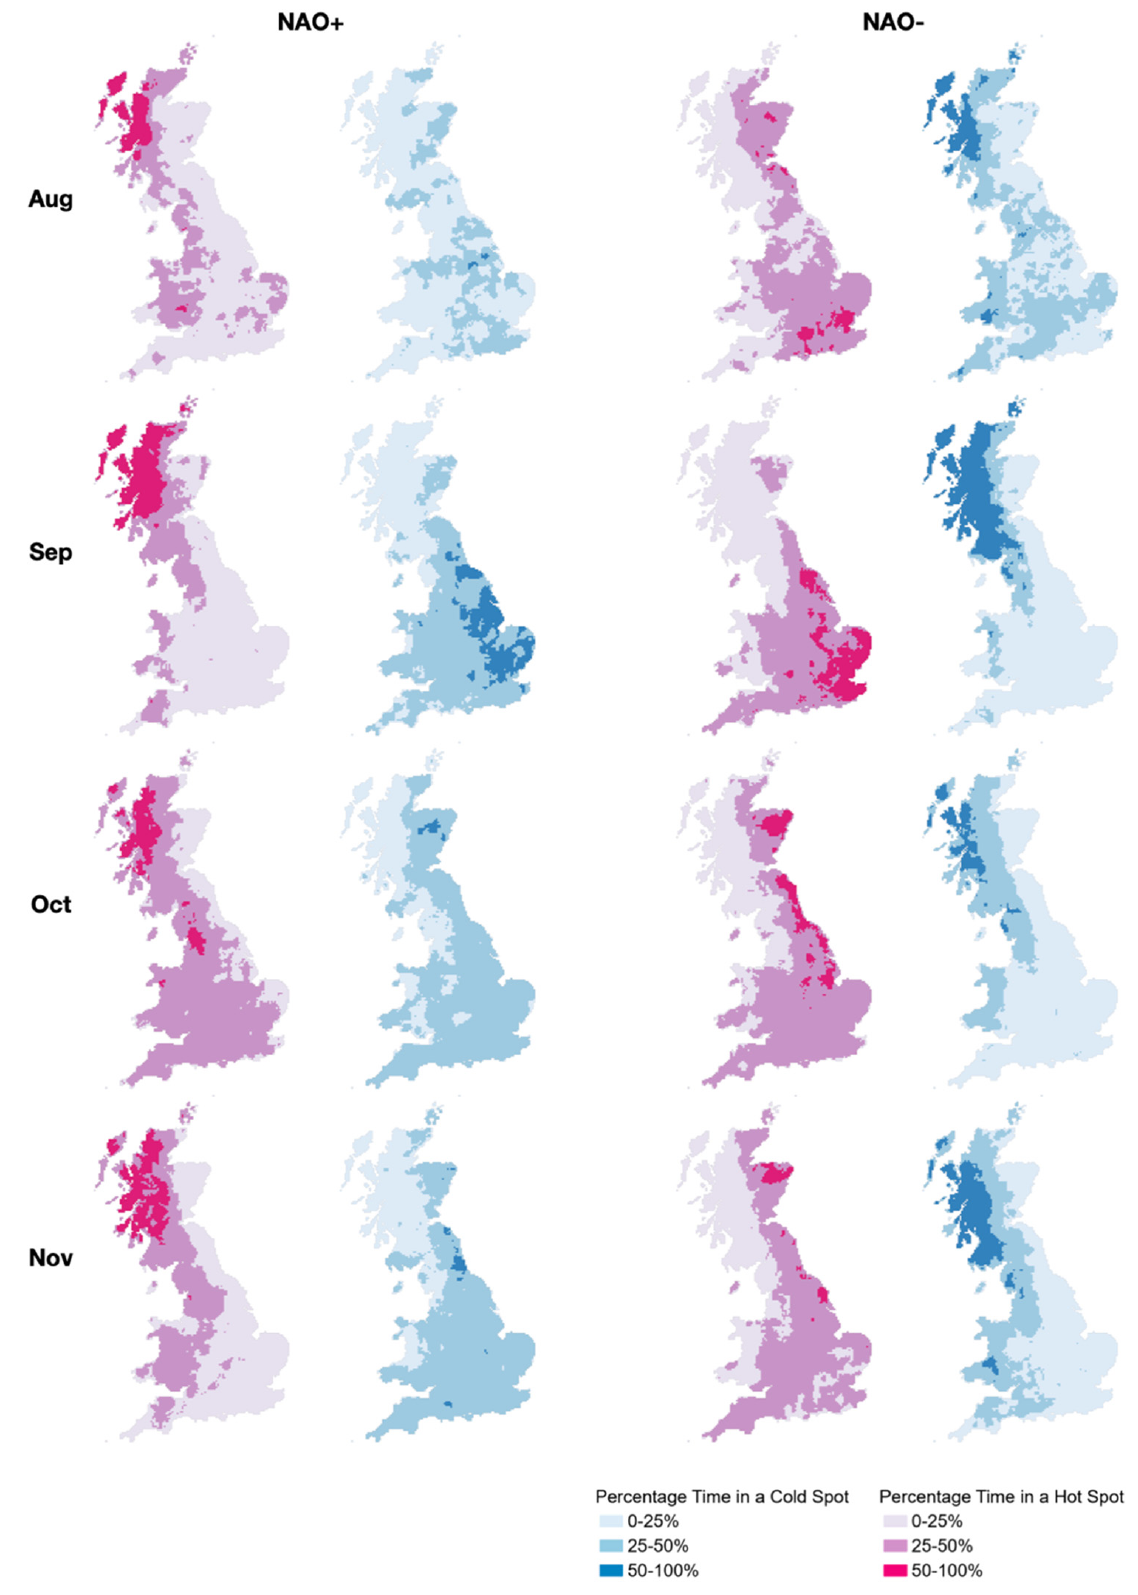
Figure A3. Disaggregated space-time hot spot results (ASON). Values indicate percentage of time in a statistically significant hot/cold spot.